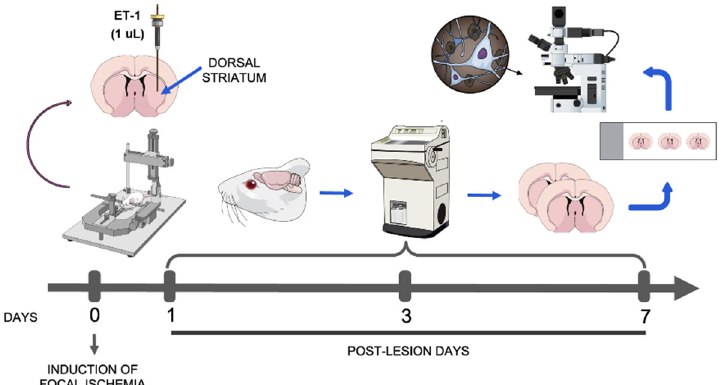
Figure 1. Schematic figure summarizing the methodological design. The animals were placed in a stereotaxic apparatus and a focal ischemia was induced by injection of endothelin-1 (ET-1) into the dorsal striatum. After the specified post-lesion times, animals were perfused and their brains sectioned and processed for being evaluated under bright-field microscopy.